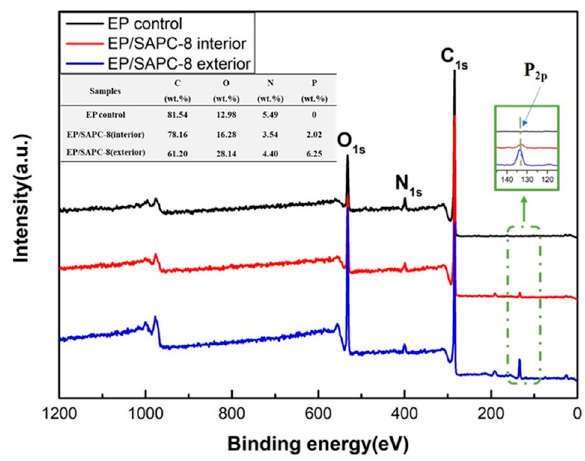
Figure 7. Digital photos ( a – d ) and SEM images ( e – h ) of the char residues from the EP control and EP/SAPC-8, respectively.